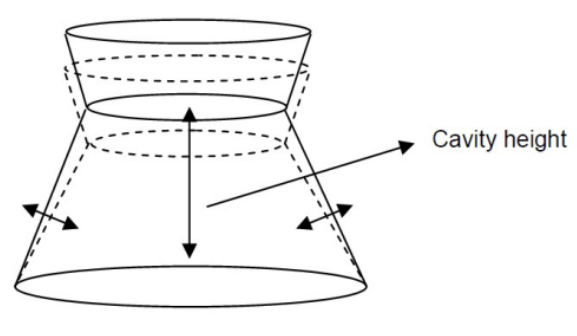
Figure 9. Radiation losses against aperture radius (solar source: 28 kWt).